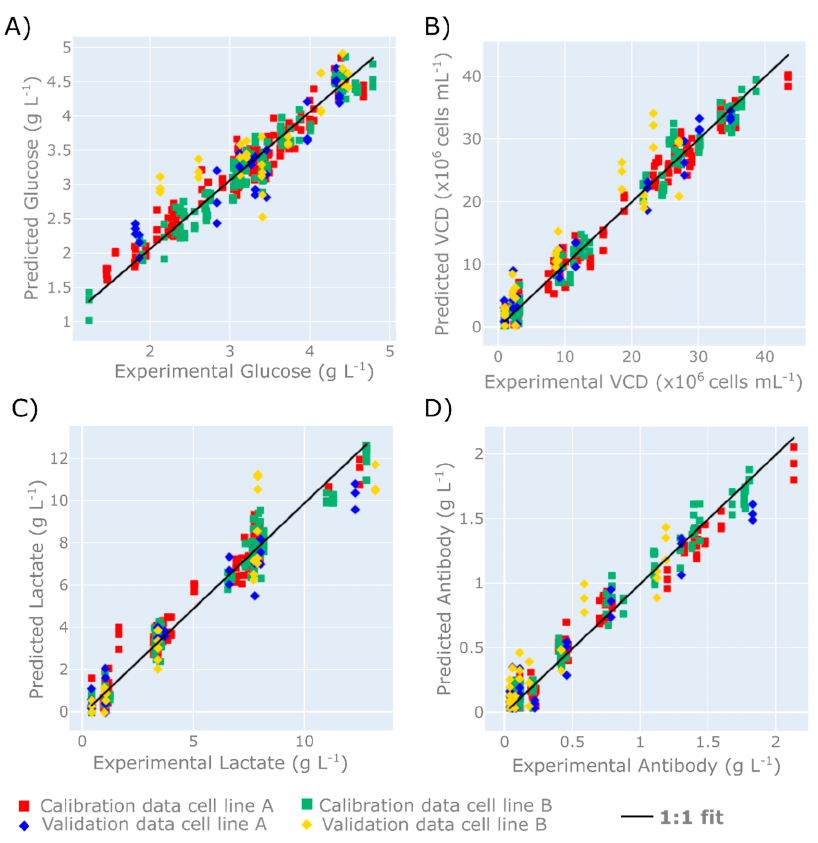
Figure 4. Parity plots demonstrating the prediction performance of four separate PLS models, highlighting the calibration and validation data sets of cell line A and B for ( A ) glucose concentration, ( B ) viable cell density (VCD), ( C ) lactate concentration, and ( D ) antibody concentration. Four separate PLS models were built utilising 7 latent variables for each variable investigated, and calibrated using cell culture runs 1–5 and 7–11 from cell line A (indicated by the red squares) and runs 13–17 and 19– 23 from cell line B (indicated by the green squares). The model was validated using cell culture runs 6 and 12 from cell line A (indicated by the blue diamonds) and runs 18 and 24 from cell line B (indicated by the yellow diamonds). The spectral data utilised in each PLS model were baseline- corrected spectra using a 1st order polynomial function, followed by the application of an SNV scattering scatter algorithm and a Savitzky–Golay smoothing filter.